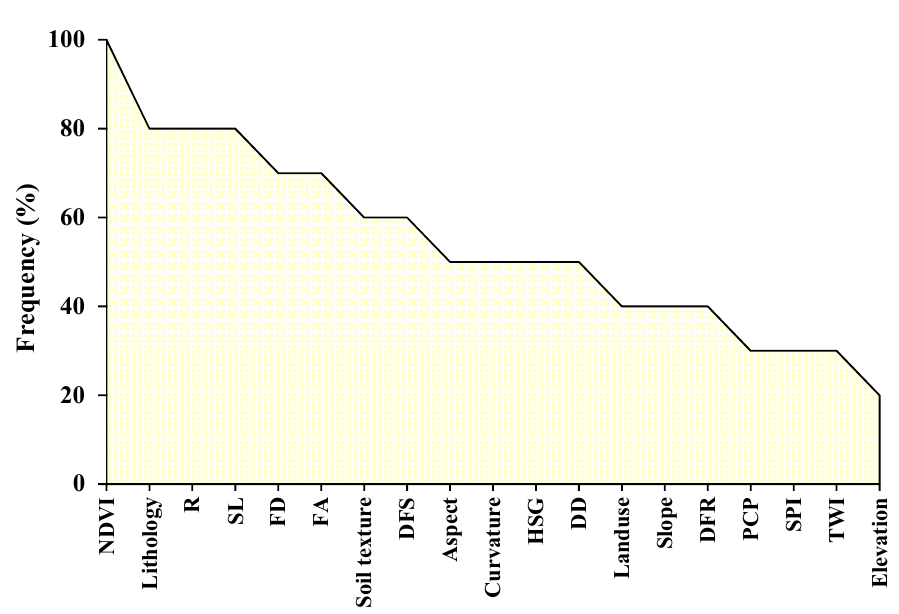
Figure 7. The percentage of selected factors in all folds.